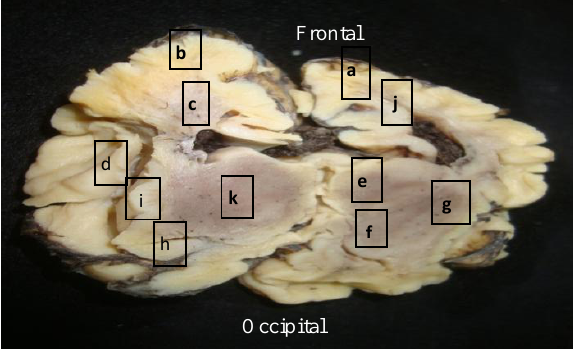
Figure, 4: Coronal section of Neonate brain showing, A: Pia matter, B: Gray matter, C: White matter, D: Insular cortex, E: Globus pallidus, F: Putamen, G: Lentiform nucleus, I: Claustrum, J: Anterior horn of lateral ventricle, H: Posterior horn of lateral ventricle, K: Thalamus